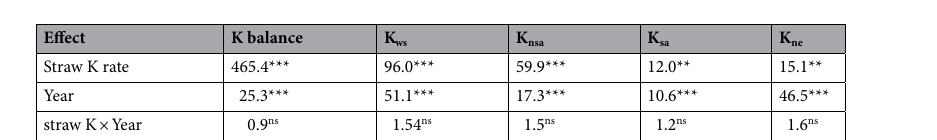
Table 2. Results of ANOVA on the effects of K rate and year and their interactions K balance and K pools from 2005 to 2018. Straw K rate, different amount of straw return, 0, 3000 and 6000 kg h m −2 per season; K ws , water soluble potassium; K nsa , Non-special adsorption potassium; K sa , special adsorption potassium; K ne , non-exchangeable potassium; F values and significance levels are given (ns p > 0.05; * p < 0.05; ** p < 0.01; *** p <